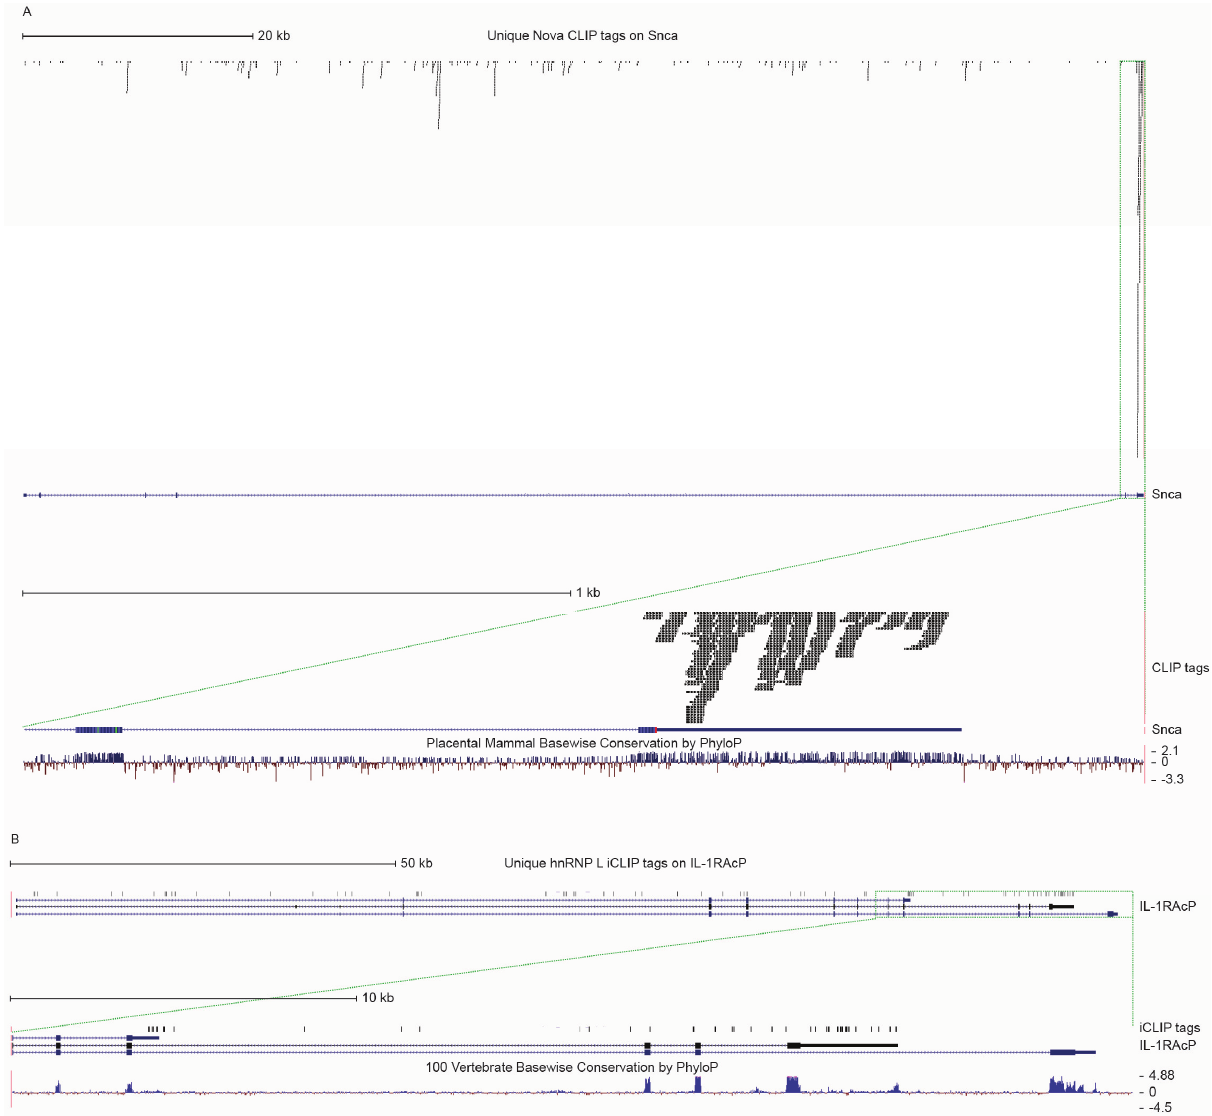
Figure 3. Proposed approach for the identification of splicing factors and RBPs that may regulate alternative splicing of specific pro-inflammatory genes and their binding sites onto the pre-mRNA. Publicly available CLIP datasets have been uploaded as custom tracks on the UCSC Genome Browser (http://genome.ucsc.edu/). For each gene, thick bars represent exons, while thin bars represent introns. Arrowheads along introns indicate the direction of transcription. The panel on top shows the entire genomic region, while the panel at the bottom shows where CLIP clusters are located. CLIP tags are indicated as bars. ( A ) Nova CLIP tags on the Snca gene on mouse chromosome 6 (assembly: mm9). Nova binds to Snca pre-mRNA in mouse brain, with robust CLIP tag clusters in the 3' UTR; ( B ) hnRNP L iCLIP tags on the IL-1RAcP gene on human chromosome 3 (assembly: hg19). HnRNP L binds to human IL-1RAcP pre-mRNA in HeLa cells. IL-1RAcP utilizes three different 3' UTR-encoding exons; interestingly, hnRNP L CLIP clusters are localized on the two more proximal 3' UTRs, while no clusters are detected on the more distal one. CLIP tags coming from the plus strand are shown in blue, while CLIP tags coming from the minus strand are shown in